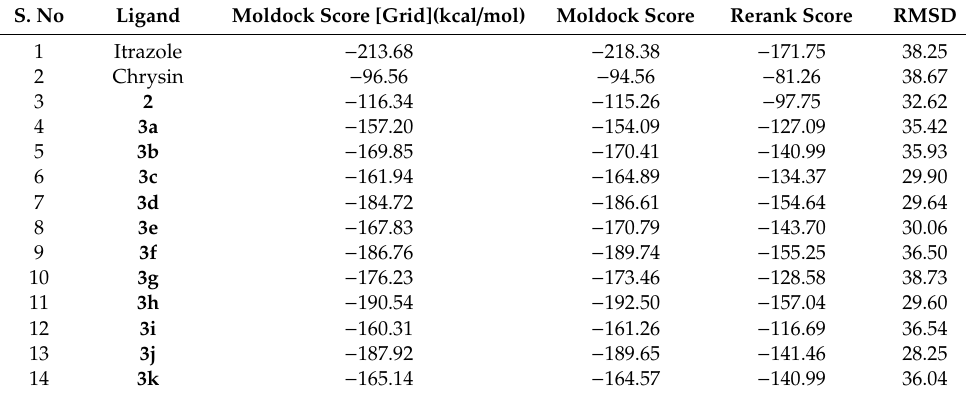
Table 4. 2-Hydroxy-3-chrysino dithiocarbamate derivatives ( 3a – k ) demonstrating highest a ffi nity (Moldock score) against S. cerevisiae (pdb id: 5EQB ) as predicted by molecular docking.